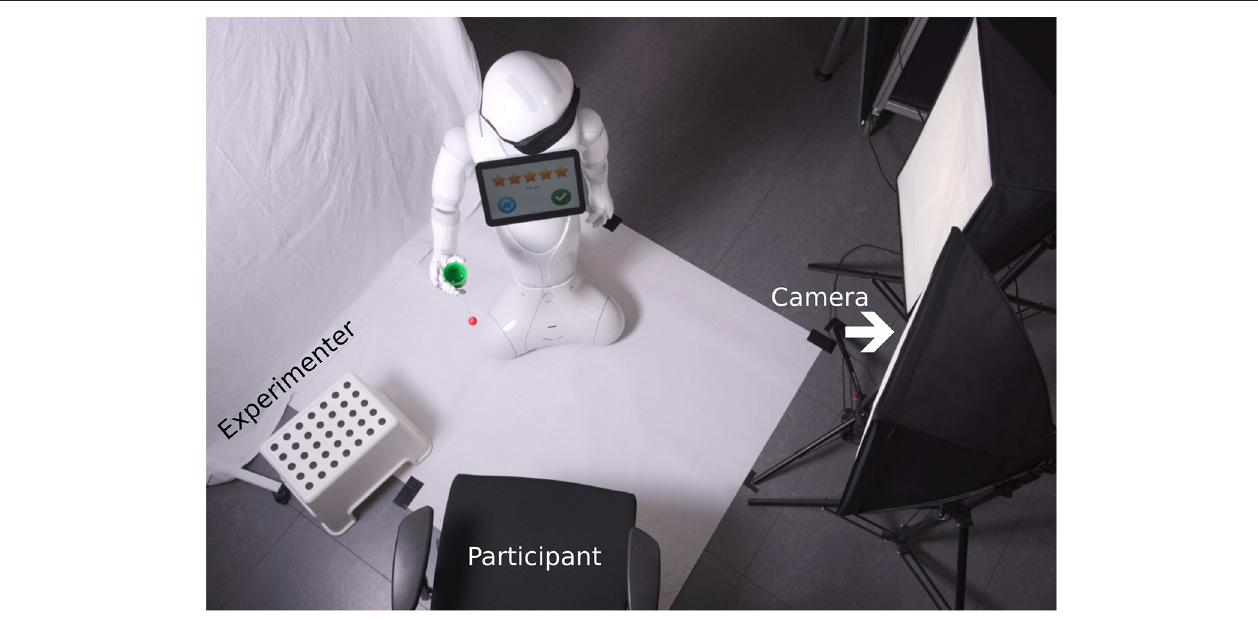
FIGURE 1 | Experimental setup from above. In the studies with optimization via the external camera setup (section 2.2), where the experimenter only returned the ball to its home position, the seat for the participant remained empty.